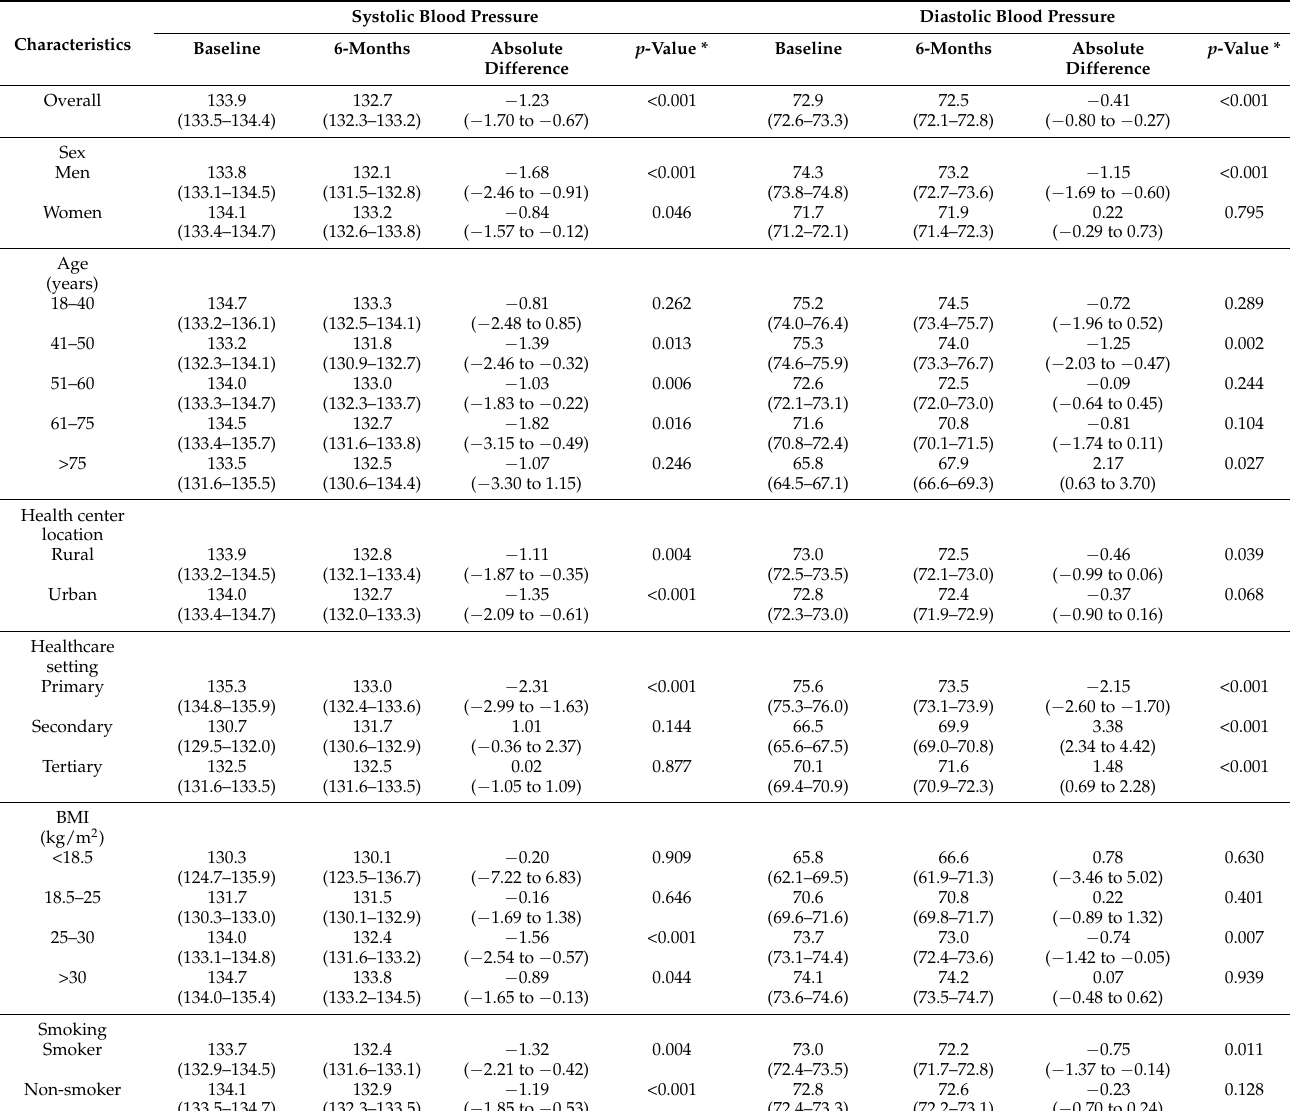
Table 2. Blood pressure at baseline and at 6-month according to the